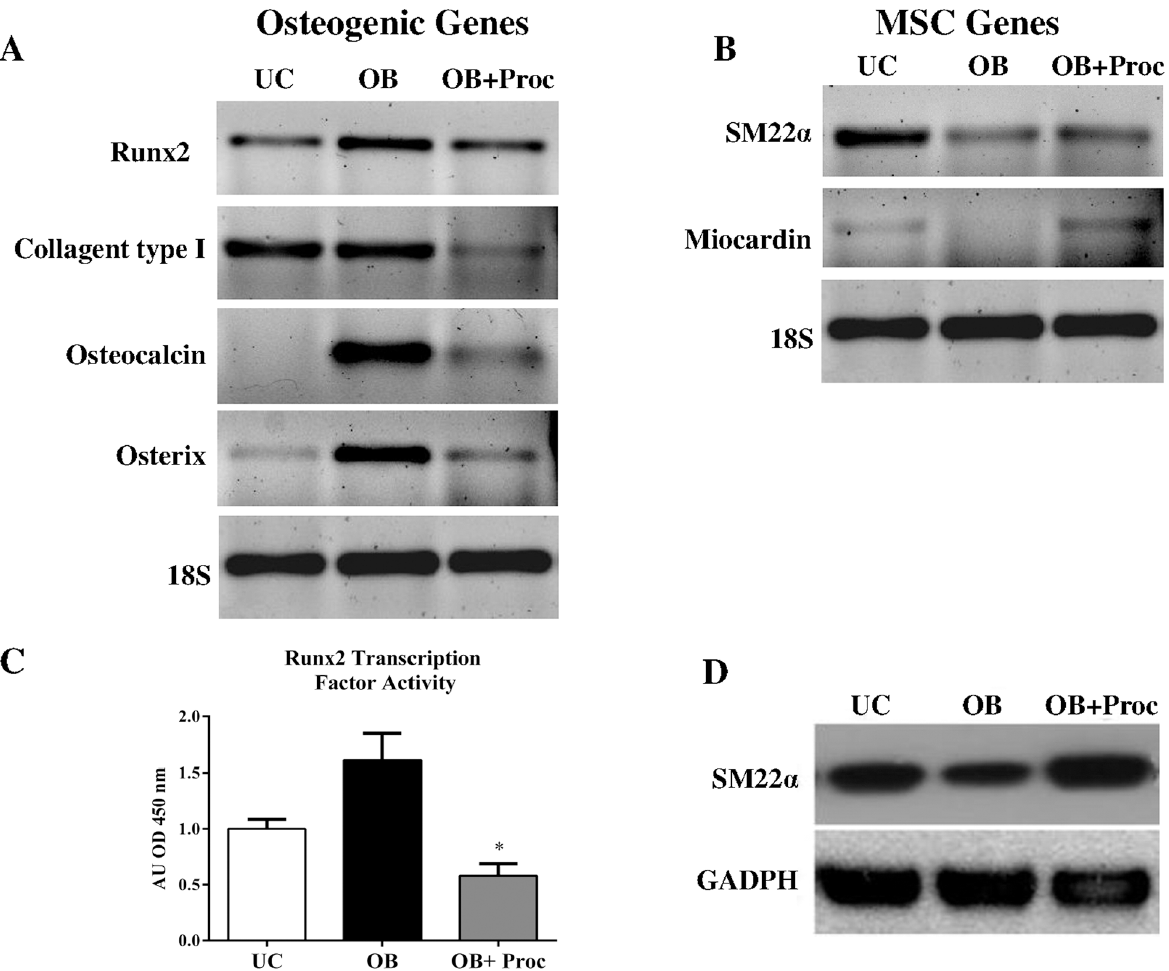
Fig 1. Procaine prevents osteo/odontogenic differentiation of mesenchymal stem cells (MSC). Changes in the mRNA expression of A) early markers of oste/odontogenesis and B) specific genes of mesenchymal stem cells (MSC) were determined by RT-PCR after osteo/odontogenic differentiation (OB), OB with procaine (1 μ M) (OB+Proc) during 21 days. The size and intensity of amplicon was electrophoresed on agarose gel (2%). Ribosomal 18S expression was used as housekeeping. C) Runx2 transcription factor activity was determined by a commercial TransAM ™ assay. Only OB cells showed to be significantly positive for this transcription factor ( * p < 0.05 vs all groups). D) Western blot for cytoplasmatic protein smooth muscle-22 alpha after 21 days of osteo/odontogenic differentiation. Images are representative of three